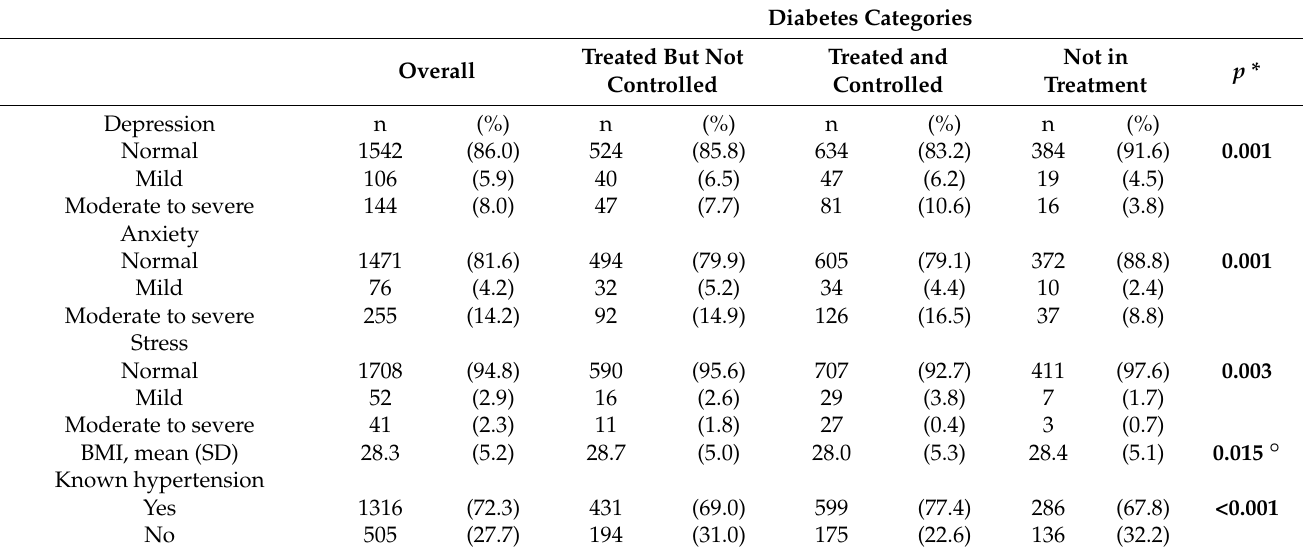
Table 2. Mental health status, BMI, and known hypertension by diabetes status (N = 1821). Diabetes Categories